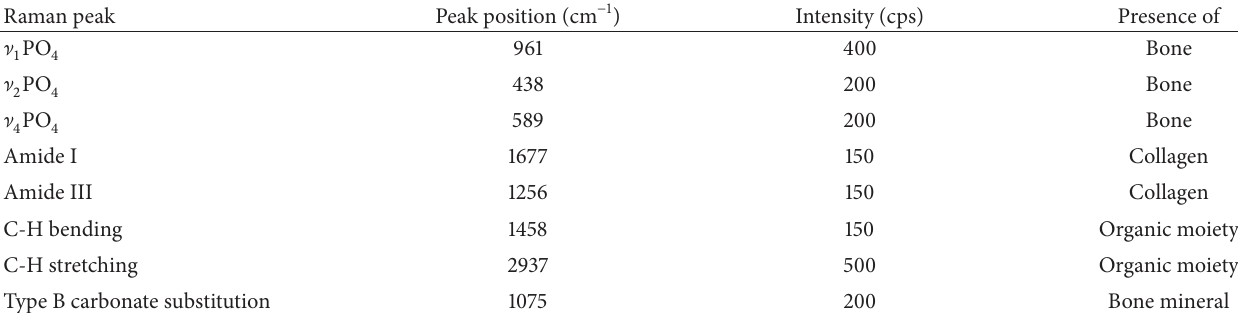
Table 1: Selected Raman bands of bone and the manually defined maximum